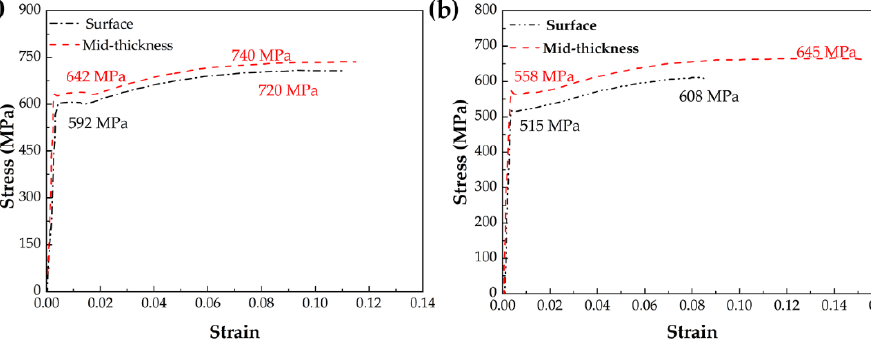
Figure 5. Tensile stress–strain curves of specimens obtained from surface and mid-thickness of steels A and B. ( a ) Tensile stress–strain curves of steel A; ( b ) Tensile stress–strain curves of steel B. In steel A, the impact energy at − 20 °C and − 40 °C is 88.9 J and 68.9 J in the surface, while in the mid-thickness, the impact energy at − 20 °C and − 40 °C is 75.3 J and 55.8 J, respectively. In steel B, the impact energy at − 20 °C and − 40 °C is 55.6 J and 30.6 J in the surface, while in the mid-thickness, the impact energy at − 20 °C and − 40 °C is 45.2 J and 28.2 J, respectively. The impact energy decreases with the decrease in tested temperature and is higher in the surface compared with that in the mid-thickness region.